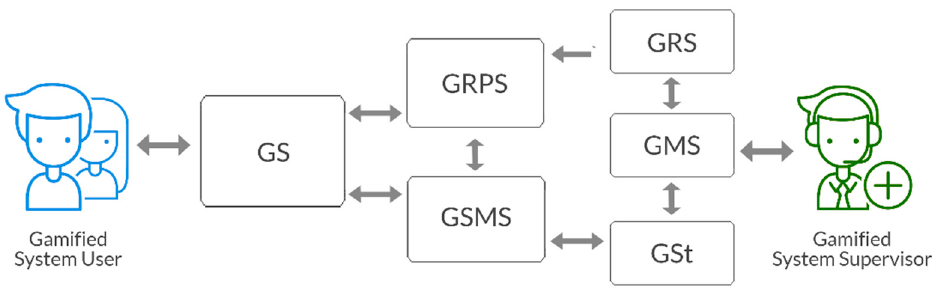
Figure 1. Inter-connections between gamification system components and users.